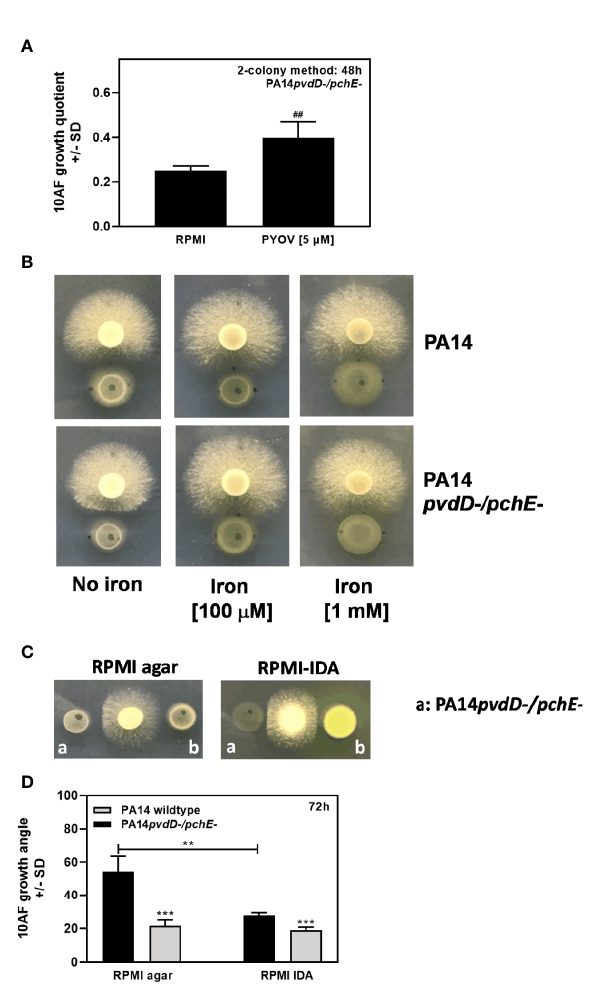
FIGURE 9 | Effects of pyoverdine or iron modi fi cation on antifungal activity on agar. (A) Six-millimeter paper disks were placed on RPMI agar. Ten microliters of A. fumigatus 10AF conidia (10 7 /ml, prepared in RPMI) was placed on each disk, and 10 µl of P. aeruginosa bacteria (10 9 /ml, prepared in RPMI) was placed 15 mm distant from the disks carrying 10AF. RPMI or 10 µl of 5 µM pyoverdine in RPMI was added to the bacterial suspension drops. Plates were incubated for 48 h at 37°C, and growth quotients were determined. (B) Six-millimeter paper disks were placed on RPMI agar, or on RPMI agar at a fi nal concentration of 100 µM or 1 mM FeCl 3 . Ten microliters of A. fumigatus 10AF conidia (10 7 /ml, prepared in RPMI) was placed on each disk, and 10 µl of P. aeruginosa bacteria (10 9 /ml, prepared in RPMI) was placed 15 mm distant from the disks carrying 10AF. Plates were incubated for 48 h at 37°C. (C) Six-millimeter paper disks were placed on RPMI agar or on iron-depleted RPMI agar (RPMI-IDA). Three disks were placed on each plate. Ten microliters of A. fumigatus 10AF conidia (10 7 /ml, prepared in RPMI) was placed on the middle disk, and 10 µl of P. aeruginosa bacteria (10 9 /ml, prepared in RPMI) was placed left and right in equal distance of 15 mm from the disks carrying 10AF. Plates were incubated for 24 h at 37°C. (D) Inhibition of fungal growth as shown in (C) was quanti fi ed by measuring 10AF growth angles (triple colony method). For each bar shown, two experiments were performed. Comparison for each group: PA14 (black bar) vs . PA14 pvdD-/ pchE- (gray bar), or as indicated by the ends of the bracket. Statistical analysis in (A, D) , t-test: two or three asterisks or pound signs = p ≤ 0.01 and p ≤ 0.001, respectively. Asterisks represent signi fi cant increases in antifungal activity; pound signs represent signi fi cant decreases.